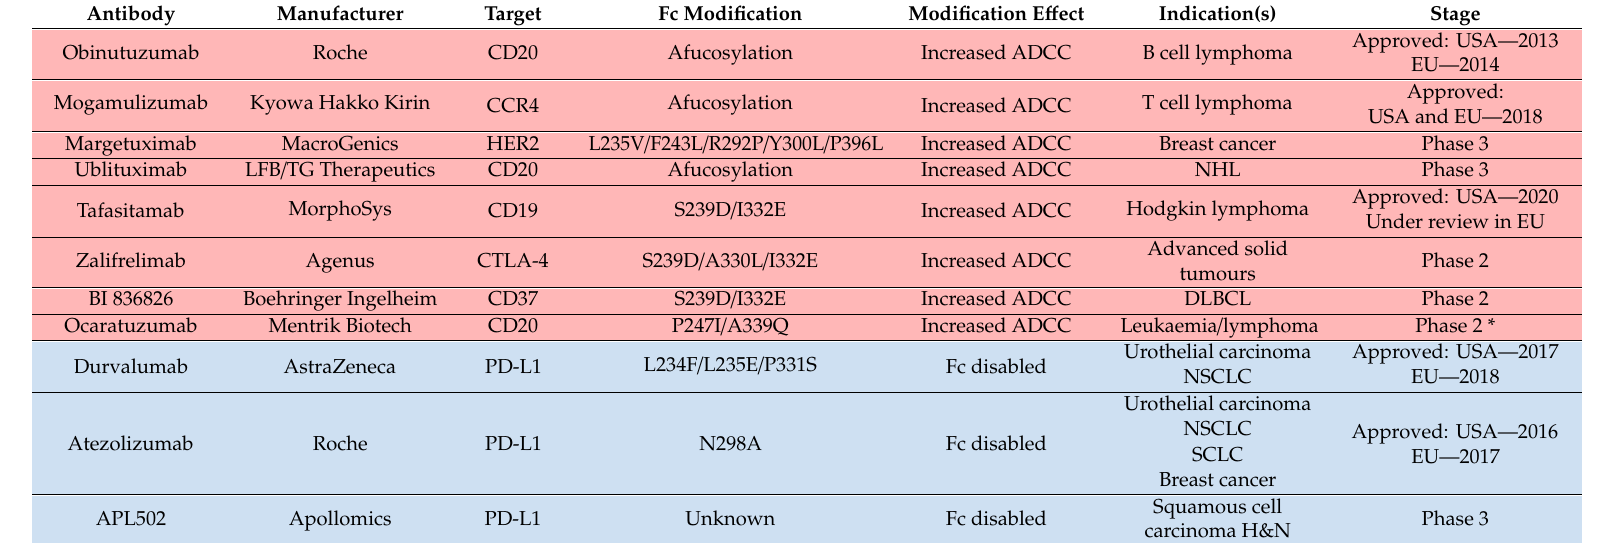
Table 2. Fc engineered antibodies currently approved for clinical use or in late stage